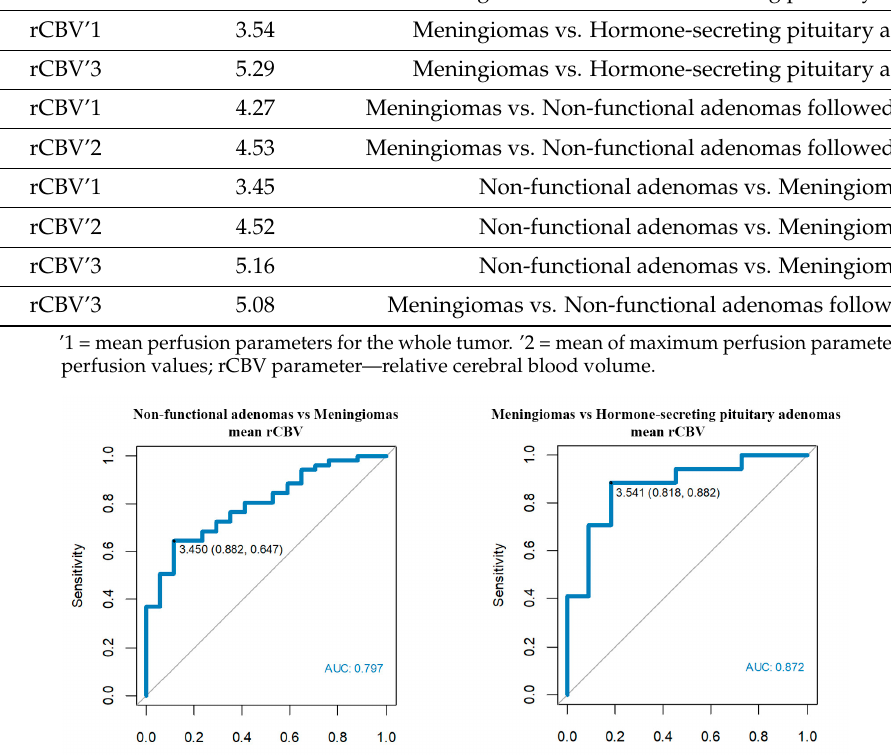
Table 2. Analysis of receiver operating characteristic (ROC) curves for rCBV parameter.